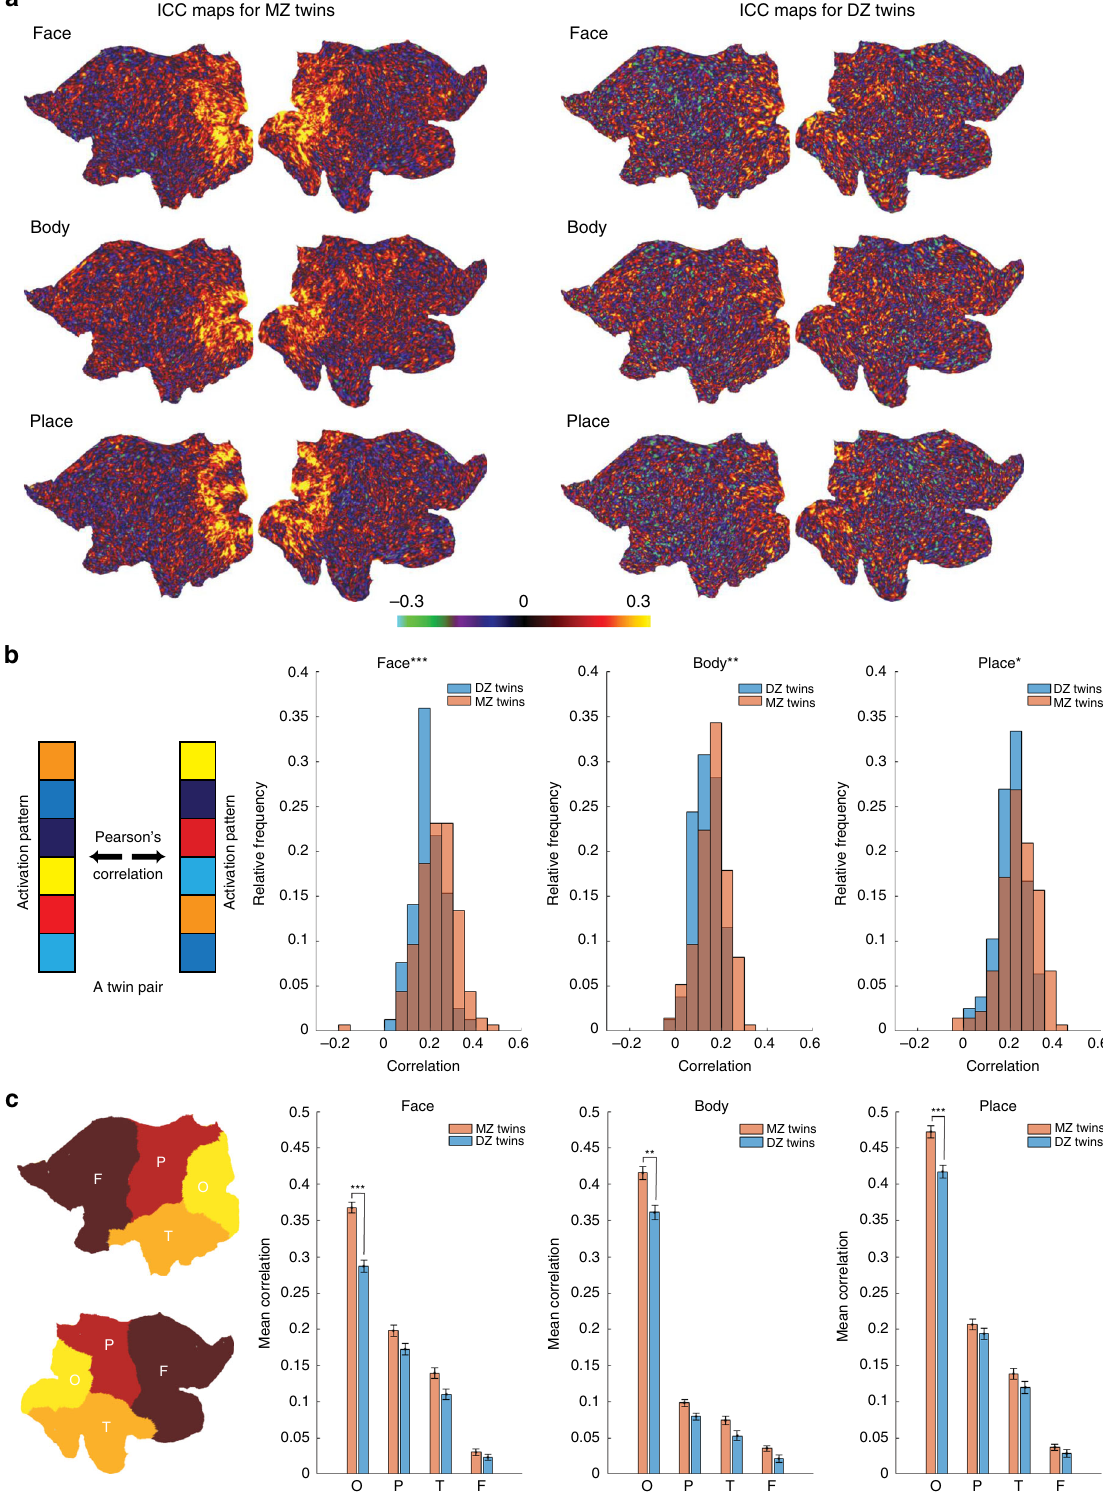
Based on the AE model, the “ genetic voxels ” (voxels having a signi fi cant genetic in fl uence) were determined (Supplementary Fig. 5; see also Methods). Figure 2b shows the maps of genetic voxels in face, body, and place areas after FDR correction. These maps, which were cross-validated (Supplementary Fig.